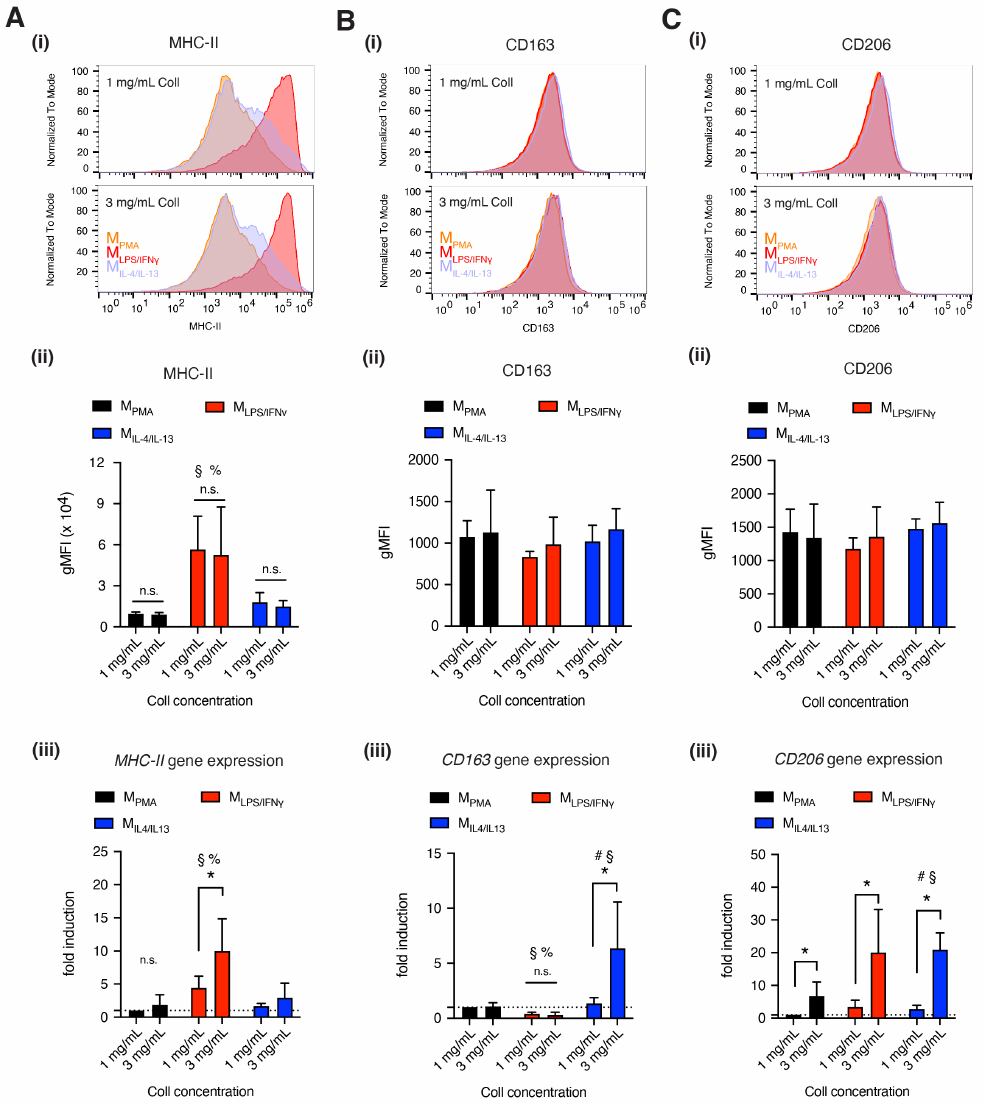
Figure 2. Quantitative analysis of THP-1 derived macrophage surface markers. ( A ) MHC-II, ( B ) CD163 and ( C ) CD206 were analyzed at both the protein level and gene expression. All subfigures, ( i ) depicts the representative histogram plot of stained cells as a function of fluorescence signal intensity. The respective quantitative analysis of geometric mean of the fluorescence intensity is shown in subfigure ( ii ) All experiments were performed at least in triplicate. Gene expression was quantitatively analyzed using quantitative polymerase chain reaction (qPCR) and the results are shown in subfigures ( iii ) Data are represented as mean ± SD; * significance level of p < 0.05. The characters #, §, % represent the significance level of p < 0.05 when compared to M PMA , M LPS / IFN γ , and M IL-4 / IL-13 macrophages,